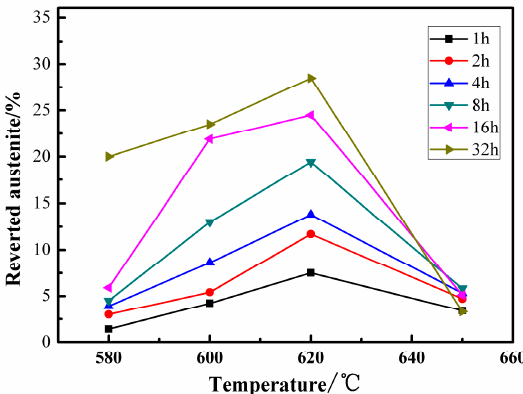
Figure 5. The volume fraction of reverted austenite tempered at different tempering temperatures and times.